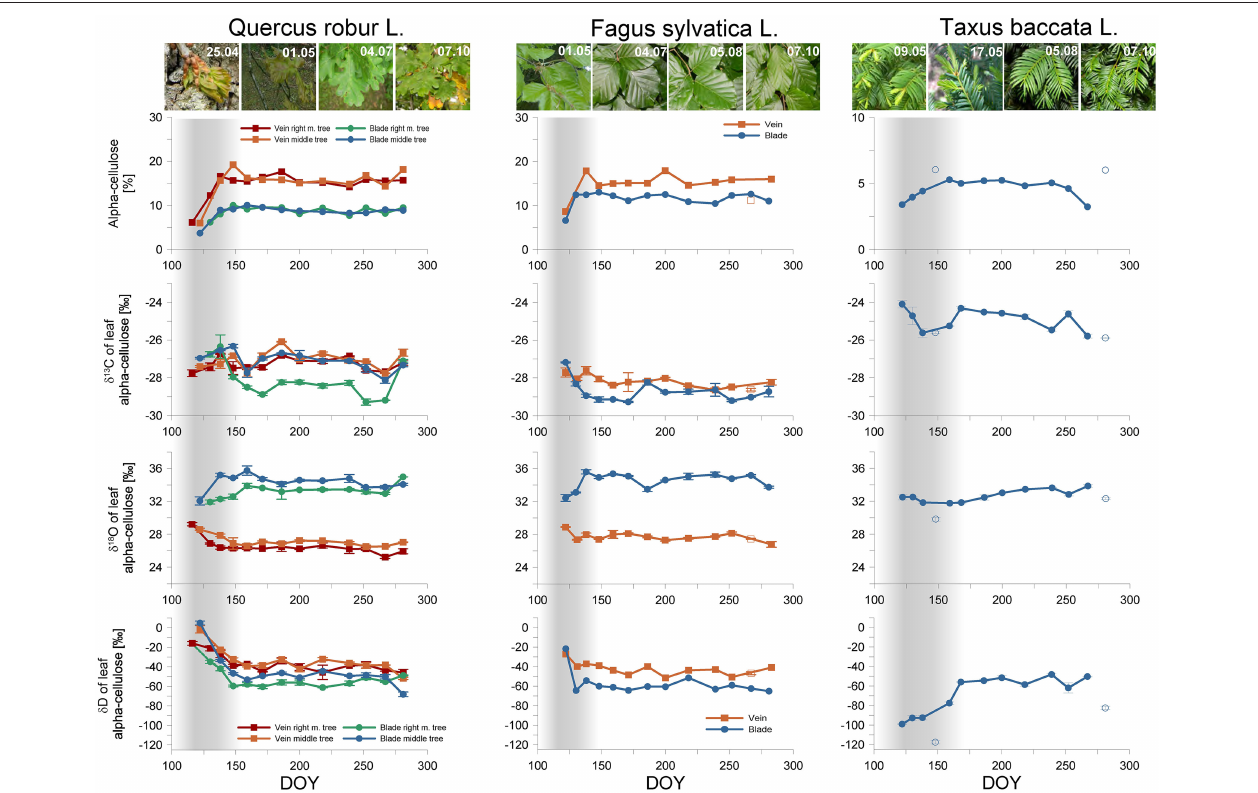
FIGURE 3 | Alpha-cellulose yield [%], carbon-, hydrogen- and oxygen isotopic composition [ h ] of oak ( Quercus robur L. ), beech ( Fagus sylvatica L. ), and yew ( Taxus baccata L. ) foliage. The x-axis represents the Day of Year (DOY) in 2012. For oaks, the red, green, orange, and blue lines represent the veins and blades of the right marginal tree, and the veins and blades of the middle tree, respectively. For the beech, the orange and blue lines represent the veins and blades, respectively. The gray shaded area denotes the juvenile period for all species. Note that squares and circles denote veins and blades, respectively. Open symbols mark values corresponding to potential cellulose extraction